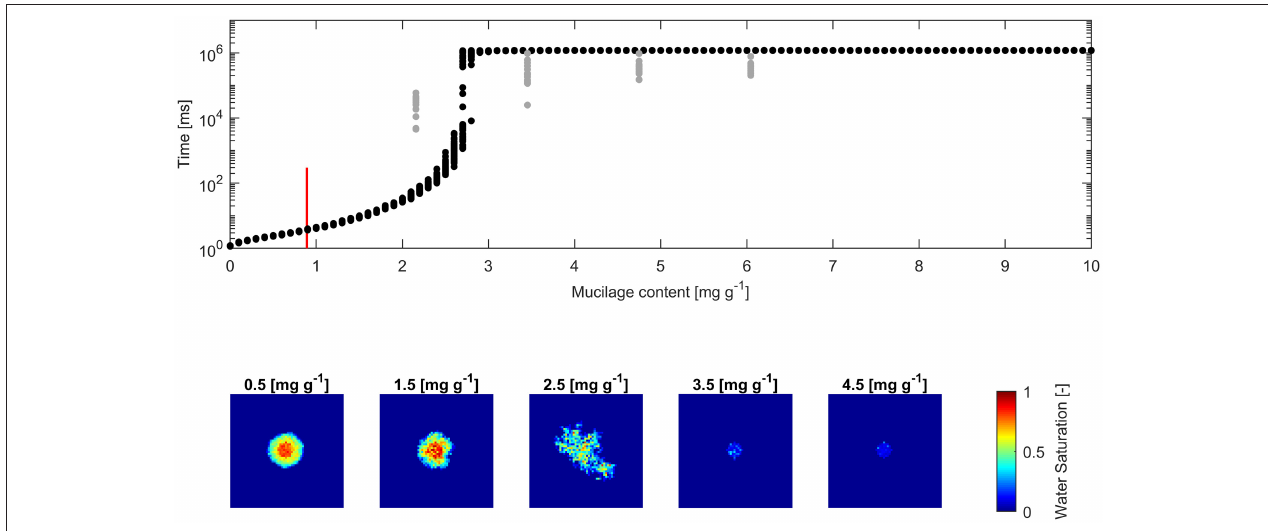
FIGURE 4 | (Top) Water drop penetration time (WDPT) derived from optically detected drop volume decrease (gray dots) and simulated WDPT (black dots) in glass beads (0.1–0.2mm in diameter); Detection limit of 300ms is indicated for the lowest measured mucilage content of 0.9mg g − 1 by a red bar; (Bottom) left to right: Top view of average final water saturation of exemplary simulations of mucilage contents across the repellent transition.